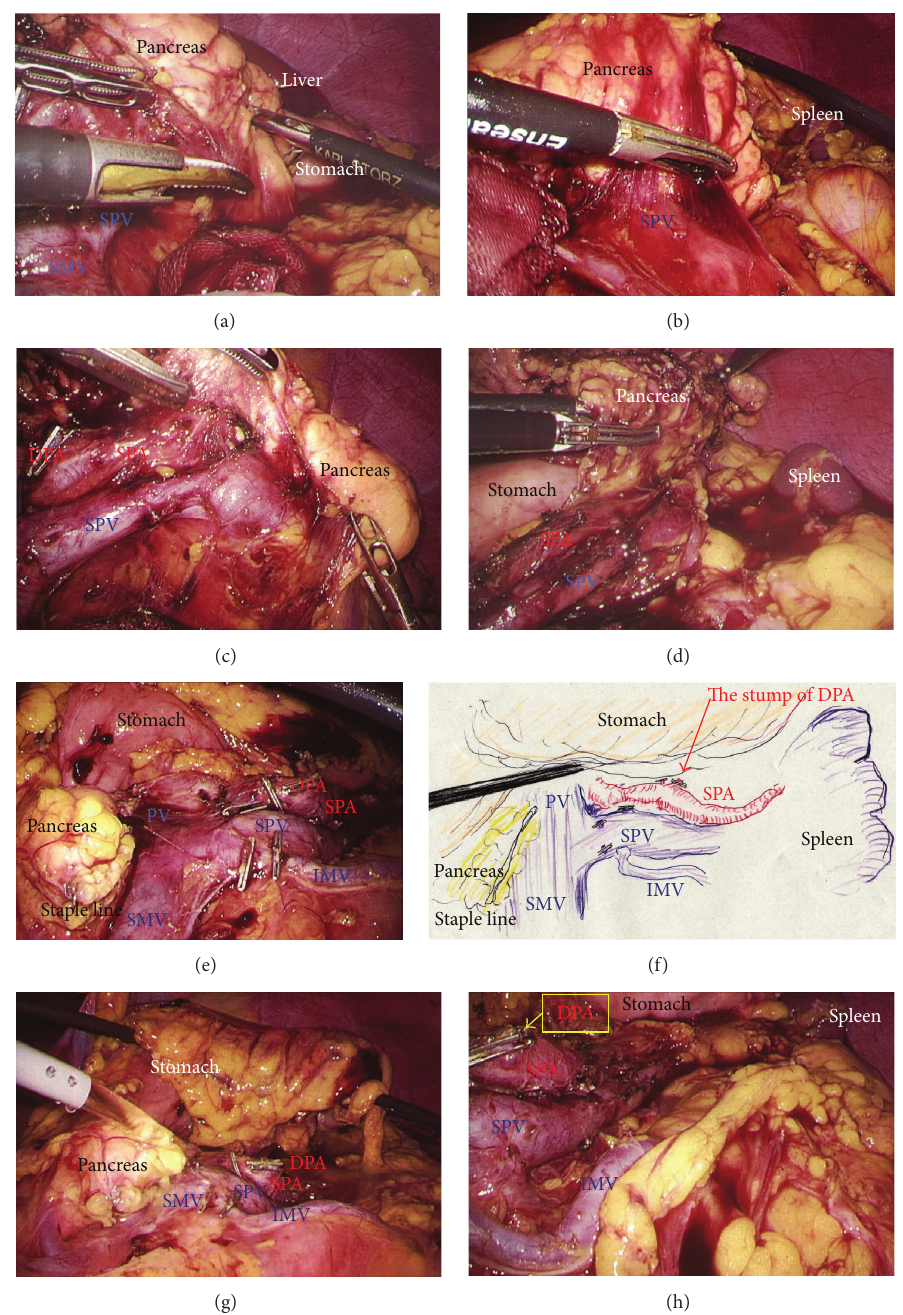
Figure 8: (a) and (b) The pancreatic body and tail were separated from the SPV. (c) and (d) The pancreatic body and tail were separated from the SPA. (e) and (f) The spleen was successfully preserved. (g) and (h) The local field was washed thoroughly and the pancreatic stump and vessel walls were checked carefully. SPA, splenic artery; SPV, splenic